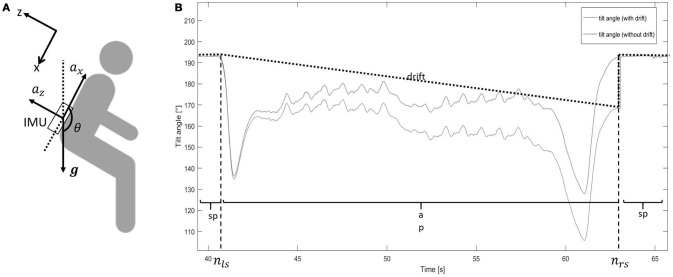
(A) Sensor location. The upper left x/z axis represents the reference frame (gravity, g). ax, acceleration in vertical direction (x-axis); az, acceleration in anterior-posterior direction (z-axis); IMU, inertial measurement unit; θ, tilt angle. (B) Tilt angle estimation from sit-to-stand and stand-to-sit movements. The blue line shows the tilt angle estimation based on integration. The black dotted line shows the drift of the integration. The red line shows the tilt angle estimation after removing the drift. ap, active period; sp, stationary period; nls, latest time index of the previous stationary period; nrs, earliest time index of the following stationary period. The step change at nrs for the “tilt angle (with drift)” line is caused by the accumulative integration error of the medio-lateral gyroscope signal. The tilt angle at that point changes from “estimated by gyroscope” to “estimated by accelerometer”.